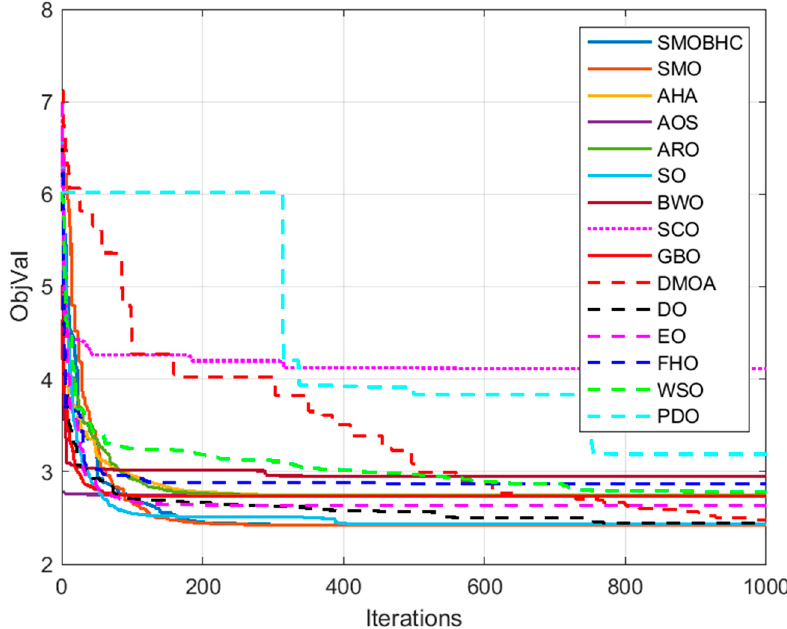
Figure 18. Comparative convergence curves of algorithms for battlefield 3 with 𝐷 = 30 .